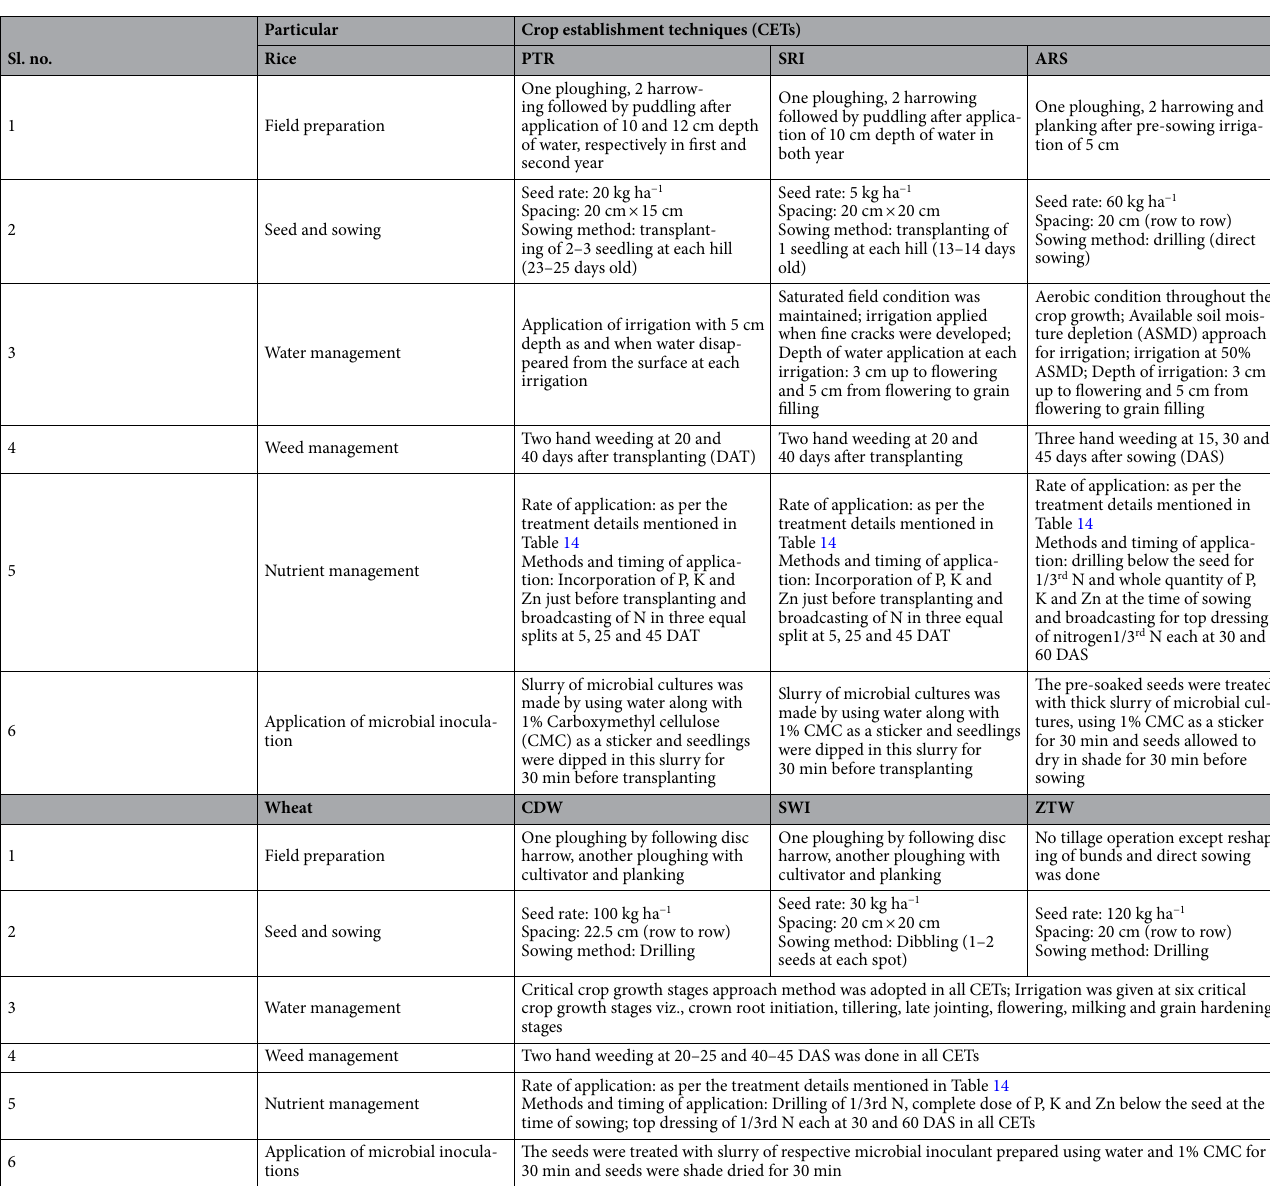
Table 15. Details of crop management in each crop establishment technique in rice and